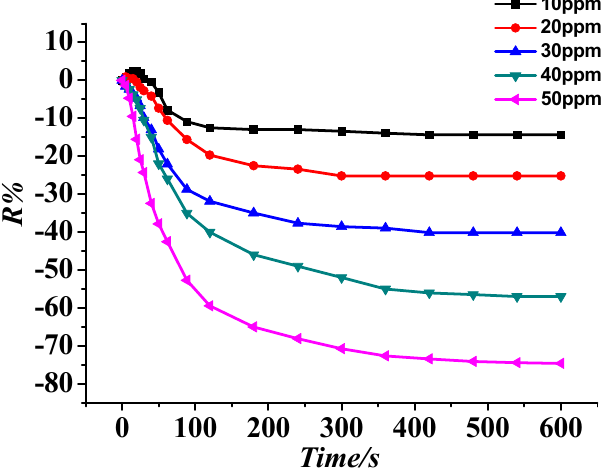
Figure 7. TiO nanotube array sensor response to different concentrations of SO 2 a 200 °C working temperature.